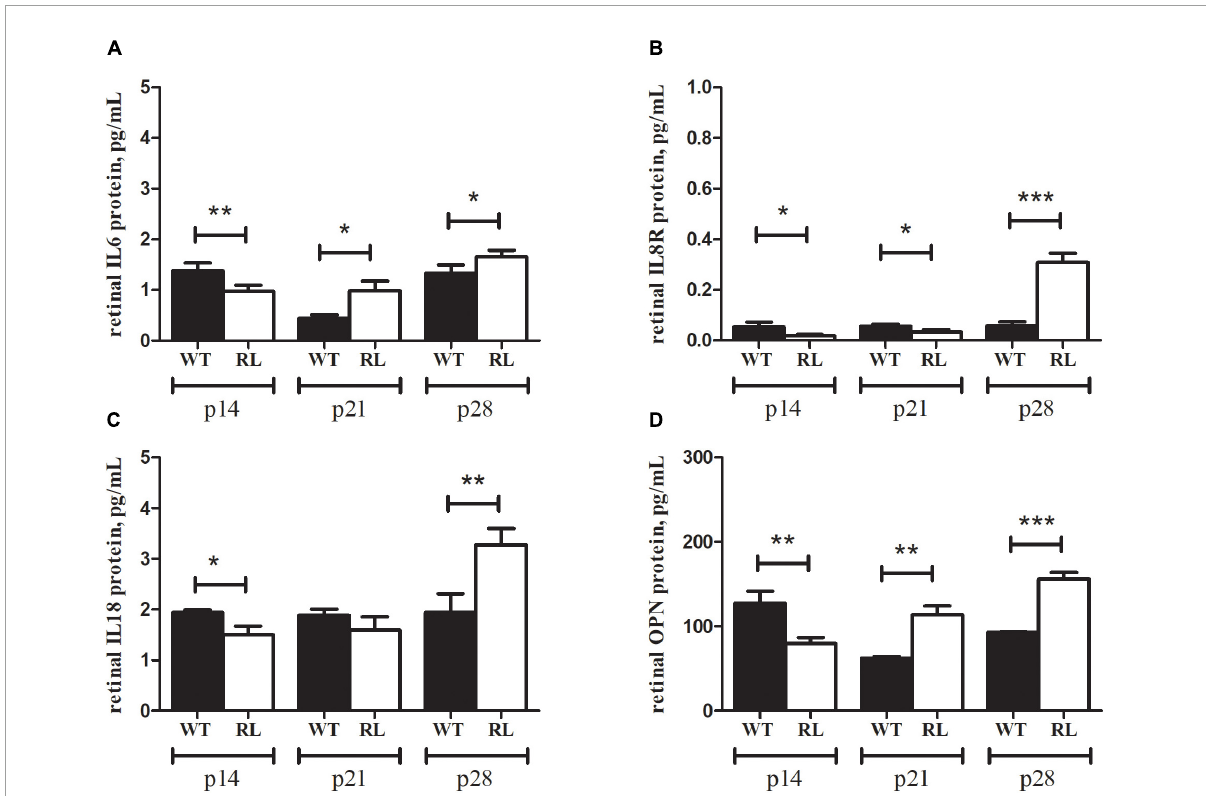
FIGURE5 IL6, IL8R, IL18 and OPN signature in Reeler retina. Ella microfluidic analysis was performed on prediluted retinal extracts from Reeler (RL) and WT mice. Bar-plot graphics show the individual values for (A) IL6, (B) IL8R, (C) IL18 and (D) OPN. Note that all biomarkers show a high significance at p28 (p28; RL vs. WT; two tailed unpaired t test with Welch’s correction). While a significant down regulation was observed for all markers at p14 (p14; RL vs. WT; Kruskal Wallis analysis with post Dunn’s multiple comparison test analysis) in Reeler mice. Specific p values are shown by asterisks (* p < 0.05; ** p < 0.01 or *** p <